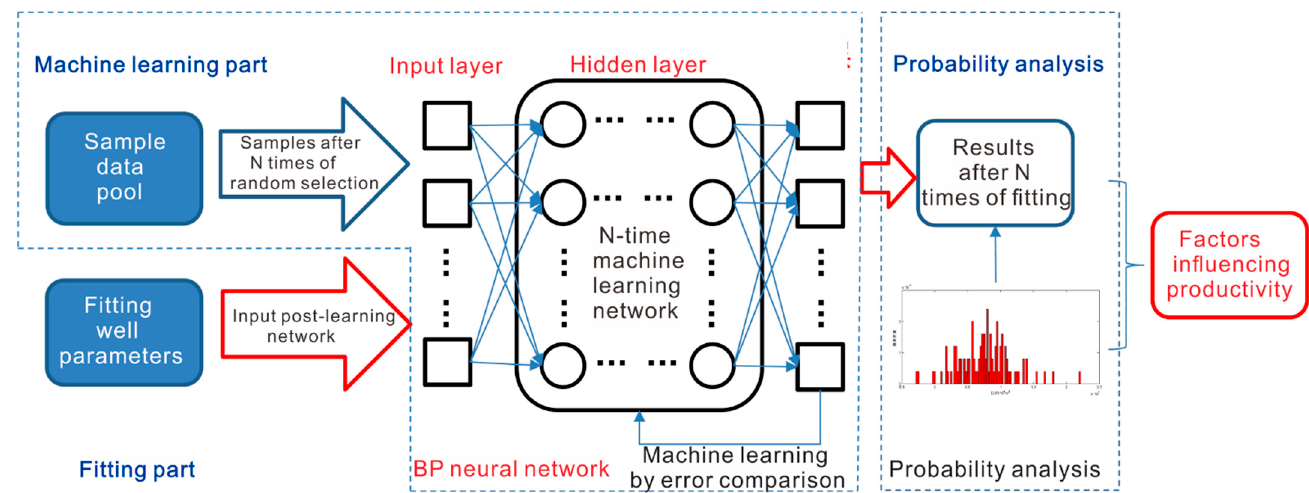
Figure 3. Schematic diagram of random BP neural network analysis method.